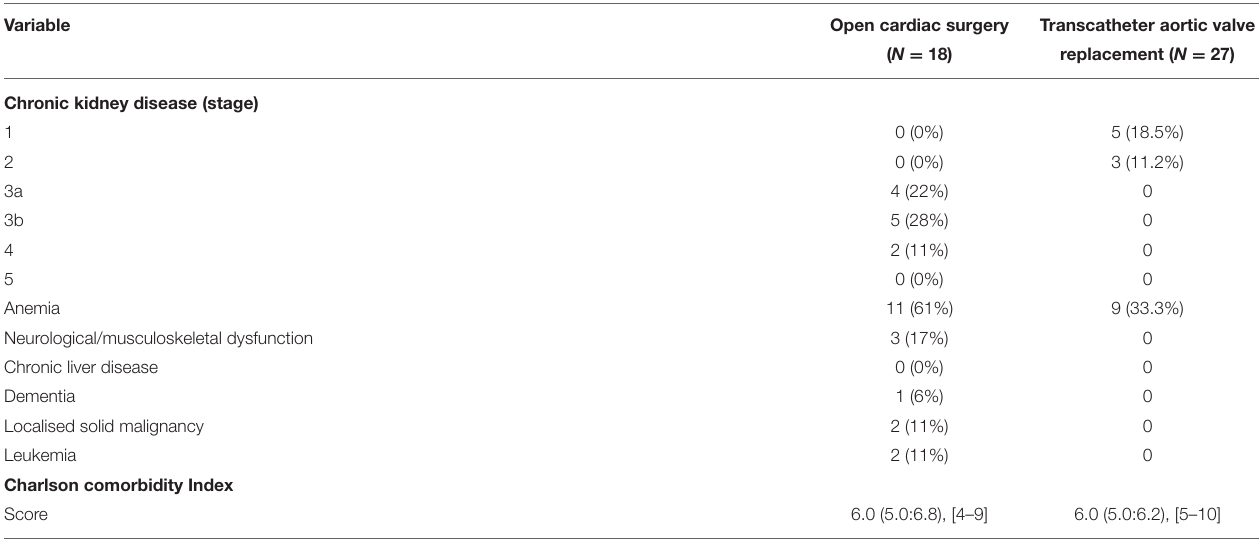
Polypharmacy was